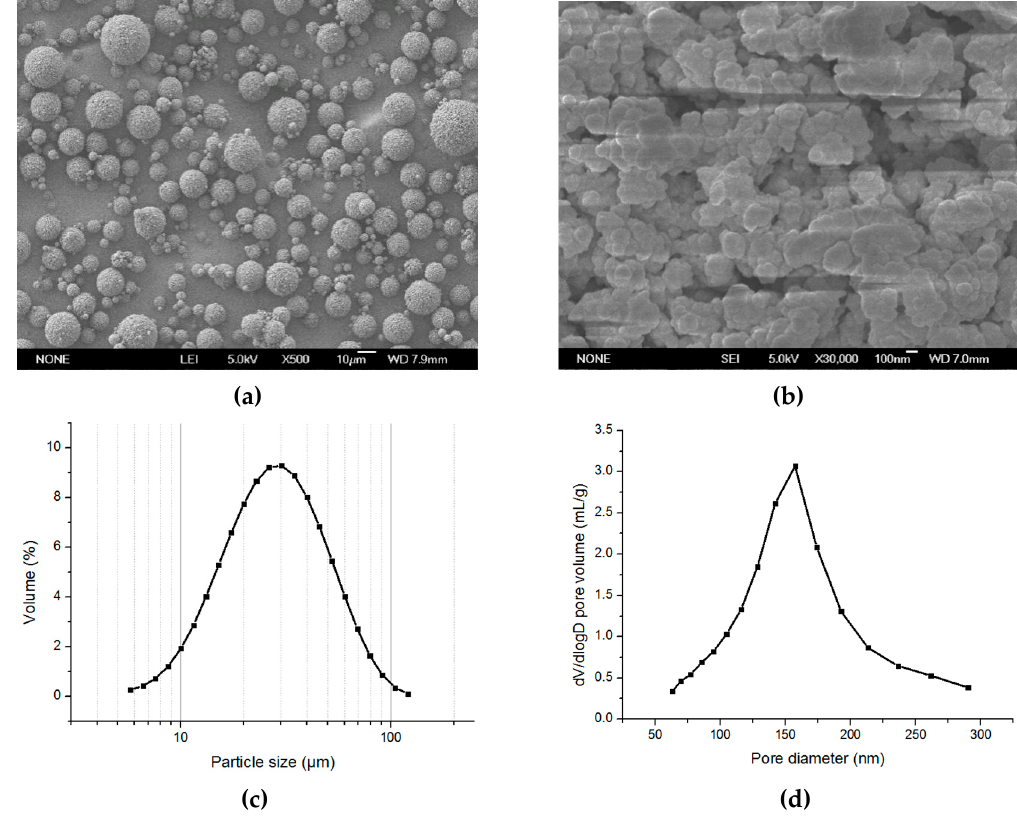
(b) (c) Figure 8. The photographs of the polymer microspheres by screen emulsification ( a ) SEM (×500), ( b ) size distribution, and ( c ) mercury porosimetry measurements. The pore size of the microspheres was about 90 nm (Figure 8c). Because the pore size was positively correlated to the amount of surfactant, we further optimized the content of Span 80 in the oil phase to control the porous structure. The pore characters with a different Span 80 is shown in